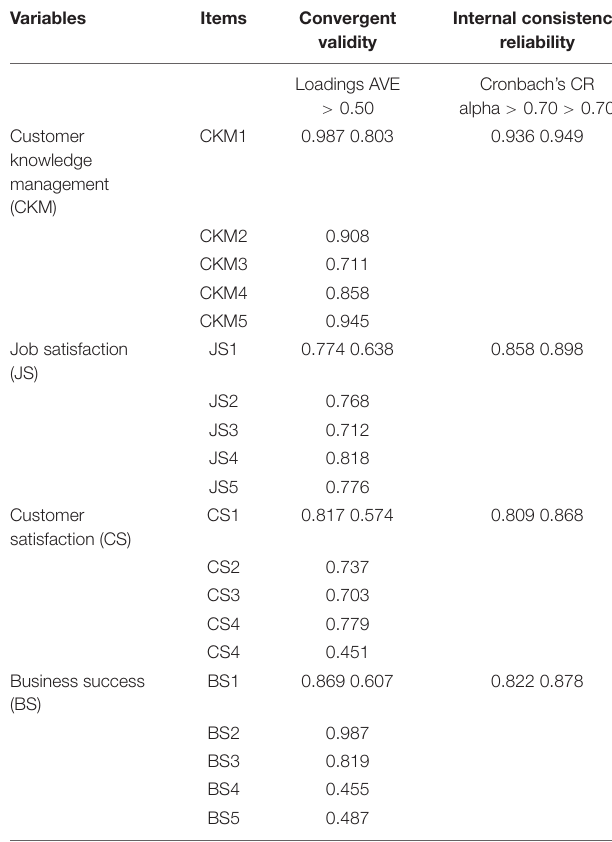
TABLE 1 | Descriptive statistics summary of the sample ( N ) = 240. TABLE 2 | Reliability analysis results.